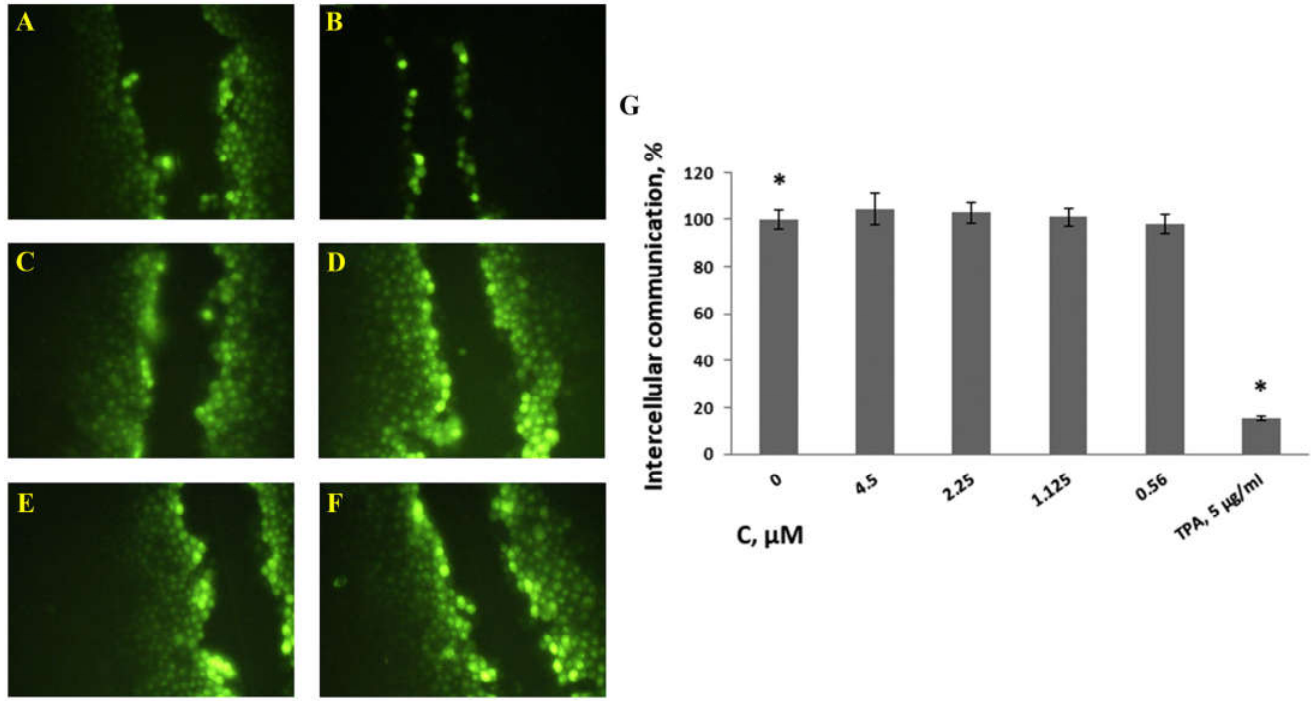
Figure 6. Micrographs of the cell monolayer in the scratch area of the control and experimental samples. ( A ). Negative control (dH 2 O). ( B ). Positive control (TPA, 5 μg/mL). Compound 12 : 4.5 μM ples. ( A ). Negative control (dH 2 O). ( B ). Positive control (TPA, 5 µ g/mL). Compound 12 : 4.5 µ M ( C ); ( C ); 2.25 μM ( D ); 1.125 μM ( E ) and 0.56 μM ( F ). LY propagation length in 4 min. Histogram of the 2.25 µ M ( D ); 1.125 µ M ( E ) and 0.56 µ M ( F ). LY propagation length in 4 min. Histogram of the cells cells proportion in cooperation with compound 12 at concentration: 104% at 4.5 μM, 103% at 2.25 proportion in cooperation with compound 12 at concentration: 104% at 4.5 µ M, 103% at 2.25 µ M, μM, 101% at 1.125 μM, and 98% at 0.56 μM (* statistically significant difference with negative con- 101% at 1.125 µ M, and 98% at 0.56 µ M (* statistically significant difference with negative control, trol, p < 0.01) ( G ). p < 0.01) ( G